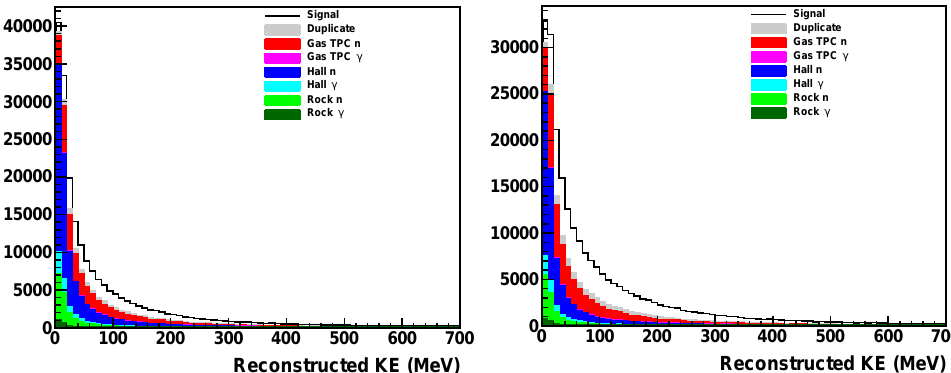
Figure 83. On the ( left ), the selected neutron sample in FHC mode. On the ( right ), the selected neutron sample in RHC mode. A significant difference in the purity can be seen at high reconstructed energies due to the facts stated in the paragraph above.